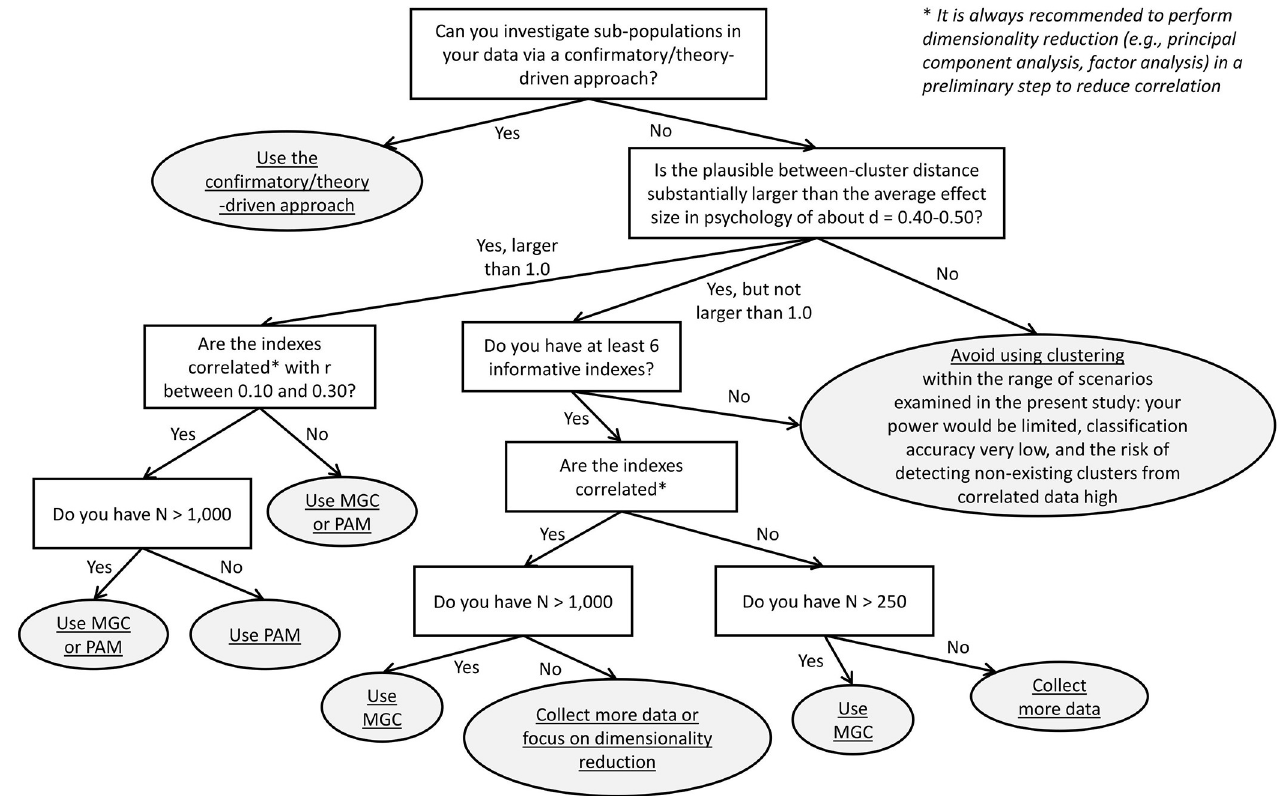
Fig 6. Decision tree on whether to use clustering based the results of the present study. The flowchart is limited to the set of scenarios examined in the present study and does not cover all possible alternatives.